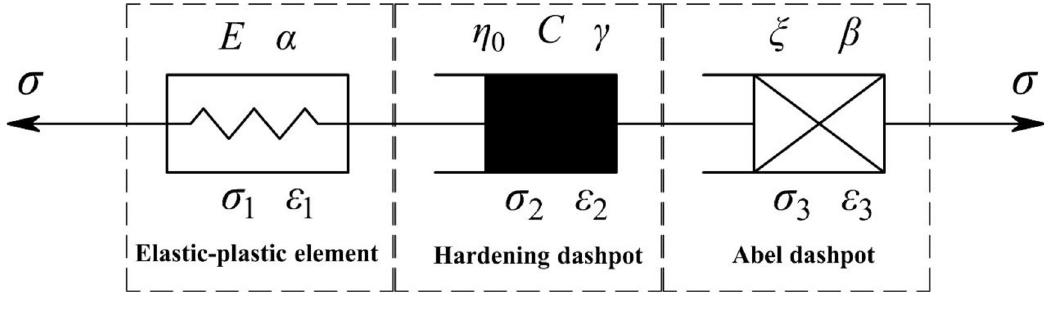
Fig 11. Schematic of the HD creep